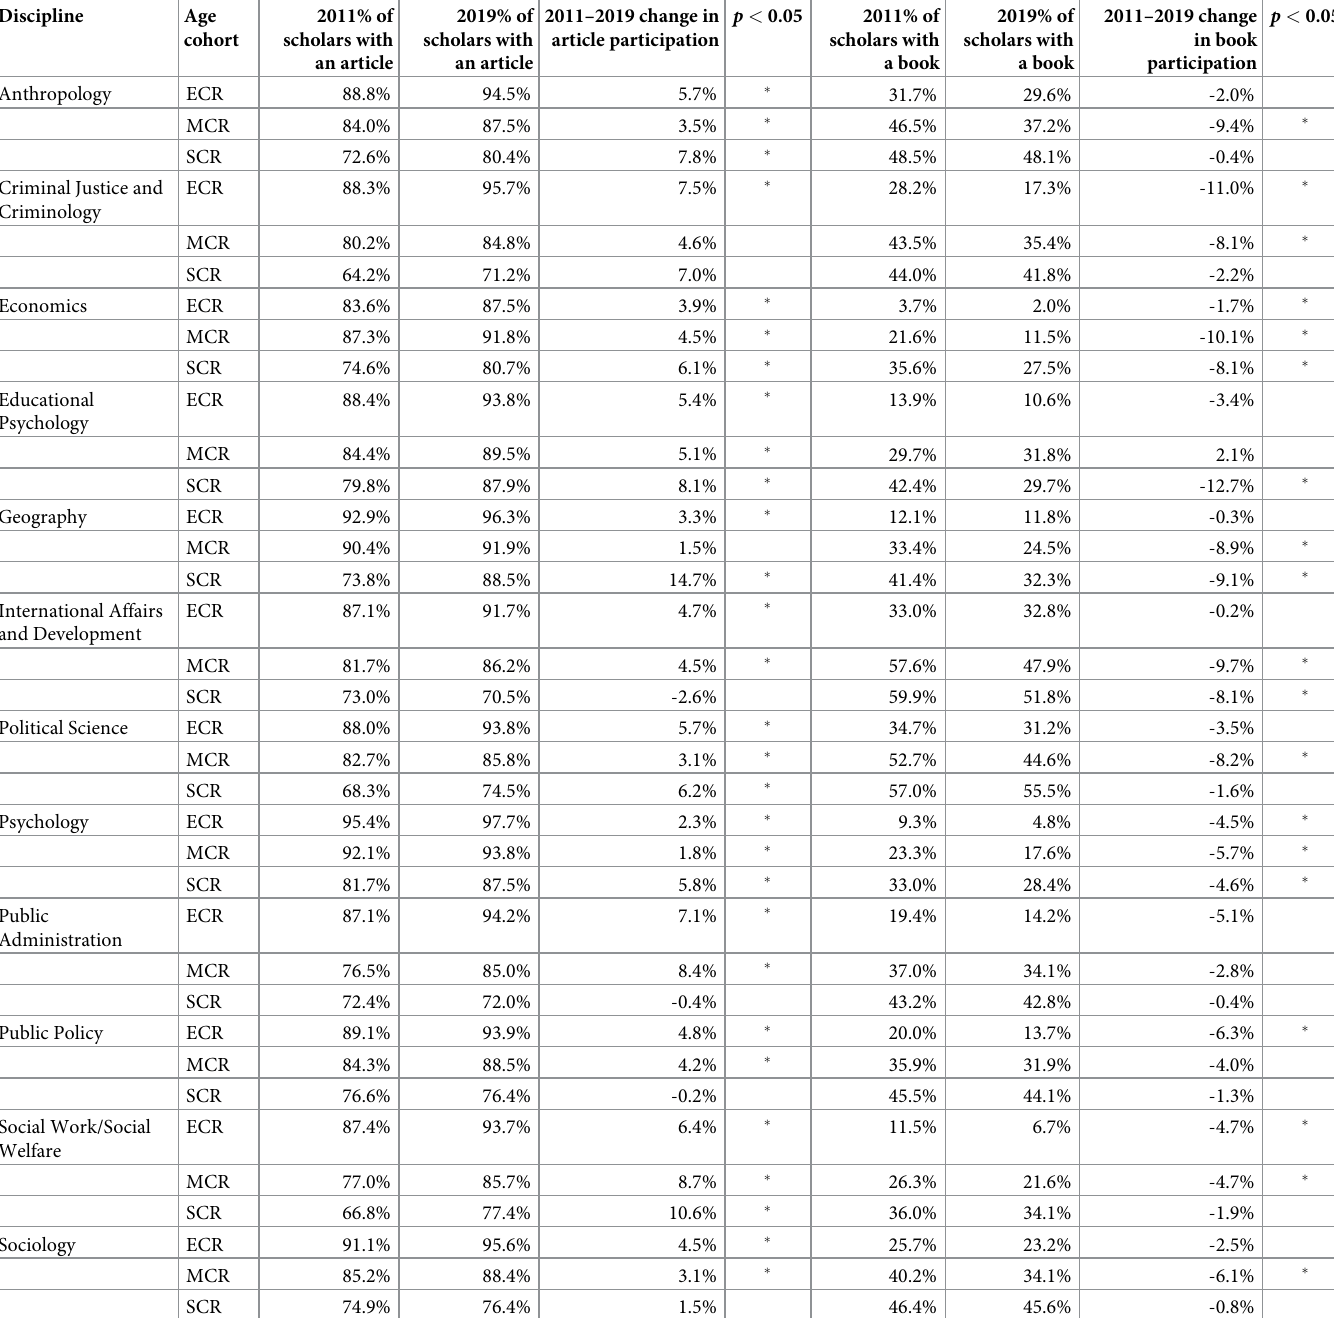
Table 5. Percent of the population of scholars by age cohort who have published at least one journal article or book in the 5-year period preceding 2011 and 2019. Discipline